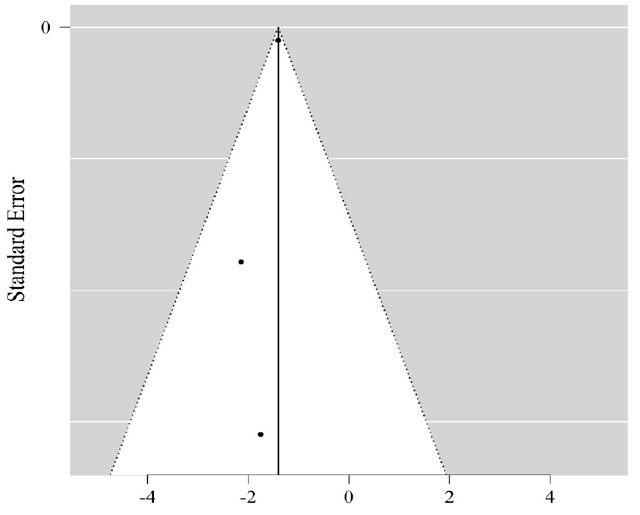
Figure 3. Funnel plot of the included studies.